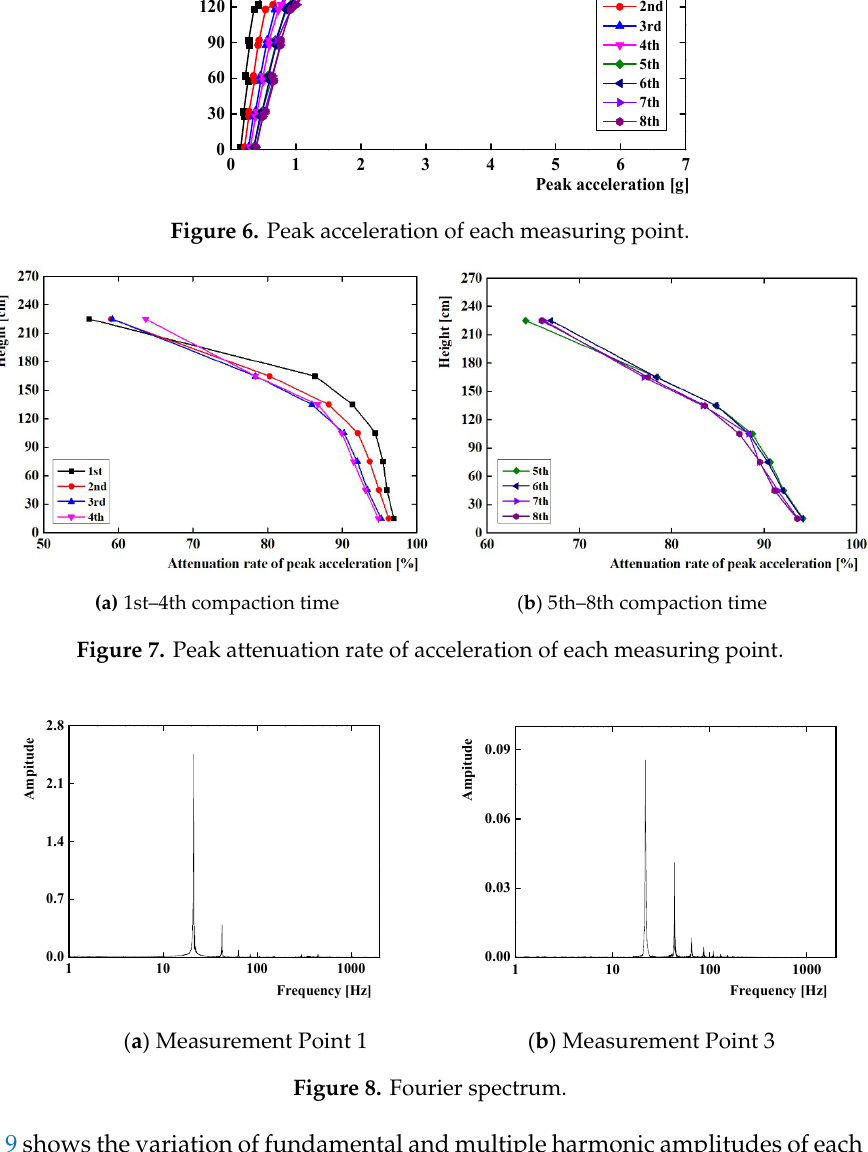
Figure 9. The concrete functional relationship among different amplitudes of harmonics can be summarized as shown: y=Ae -BX . In the formula, A and B represent the coefficient, X represents the order of harmonic and Y represents the amplitude of harmonic when its order is X.